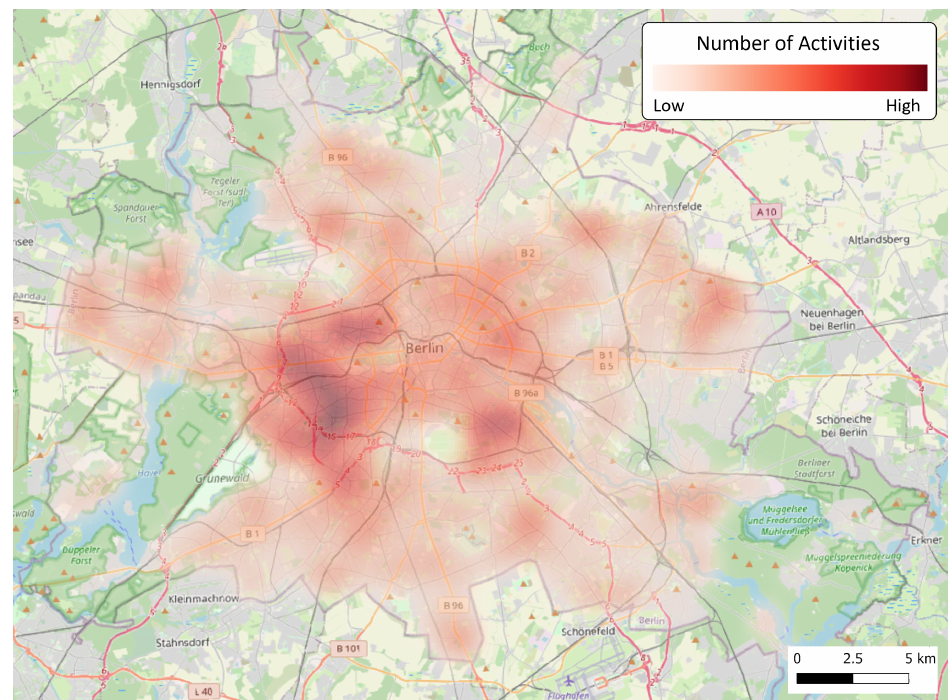
Figure 12. Spatial distribution of activities in the MATSim